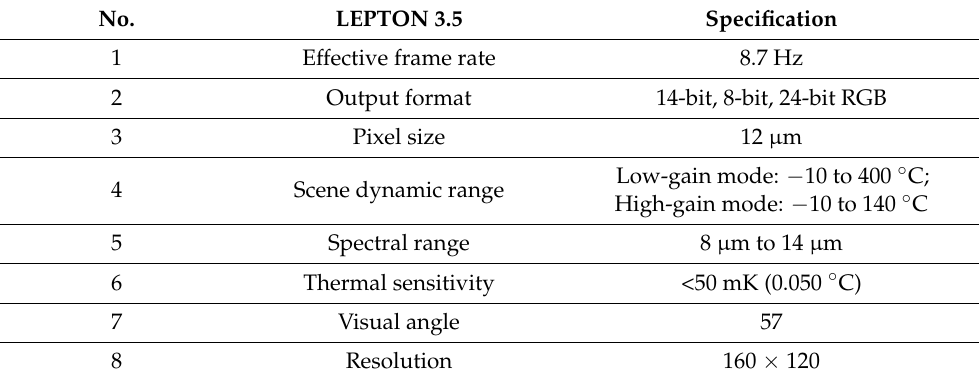
Table 4. FLIR Lepton ® specifications.